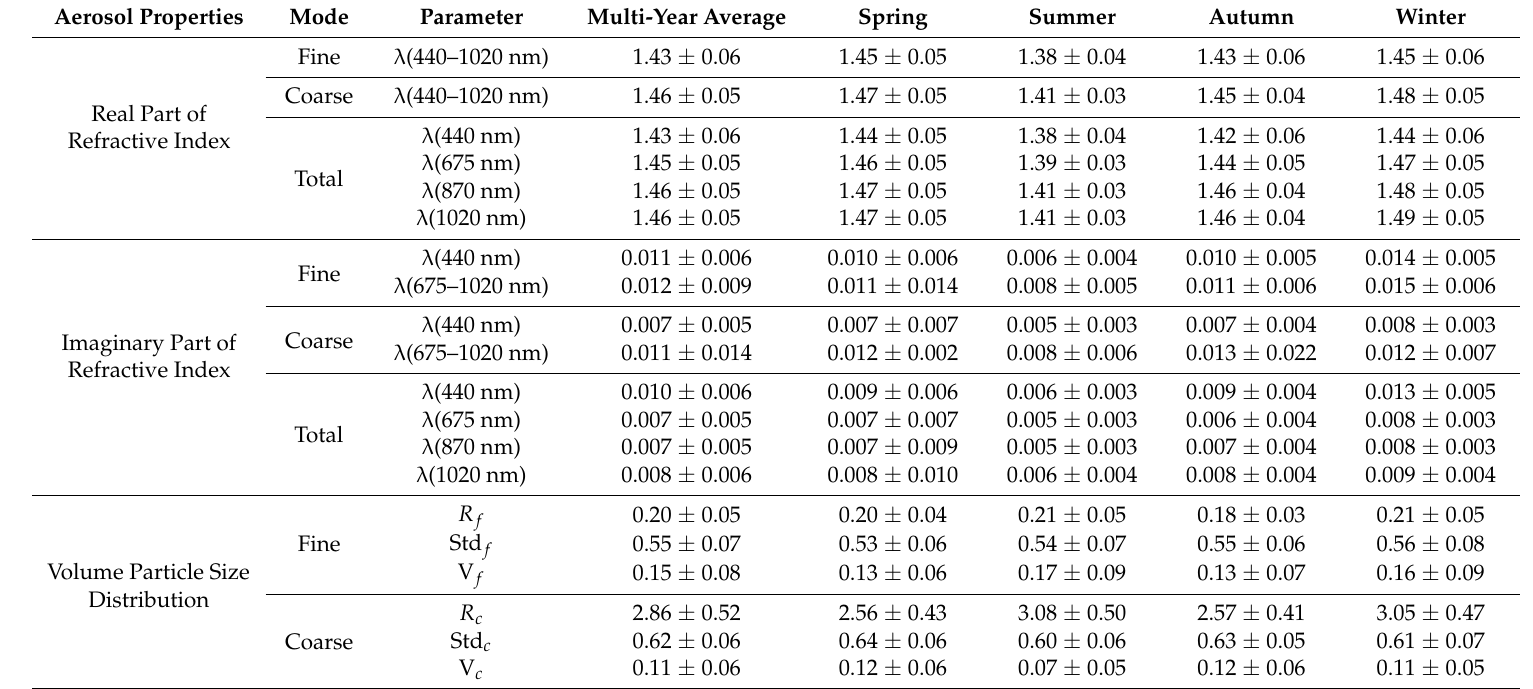
Table 2. The separated volume size distribution and sub-mode complex refractive index in different